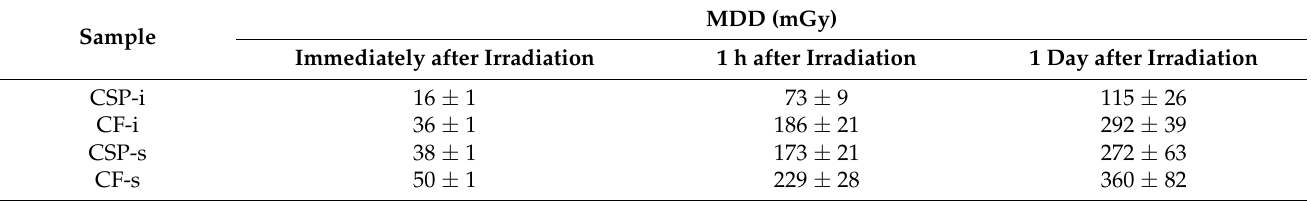
Table 2. MDDs values of camera lens glass protectors determined for various times after exposure to